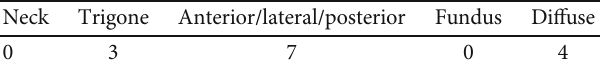
Table 2: Anatomical localization of secondary tumor deposits within the urinary bladder of the reviewed